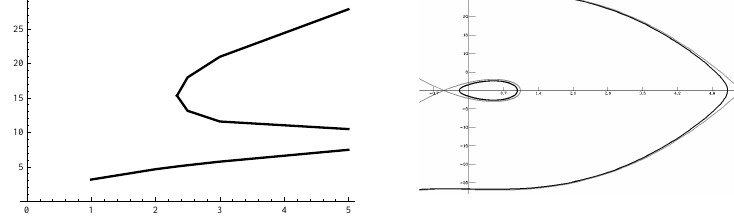
Figure 5. Solutions, entering the saddle points at ( a, 0) and ( c, 0) in grey, solutions of the problem in